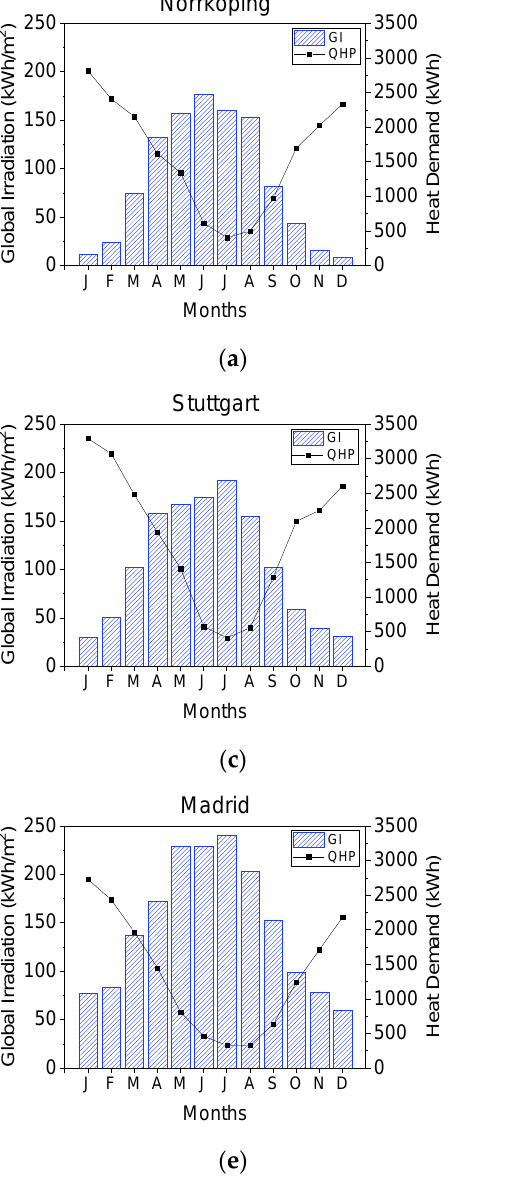
Figure 4. Monthly values for global irradiance (primary vertical axis) and total heat demand (secondary vertical) axis for all examined locations. ( a )–( f ) shows global irradiance and total heat demand respectively for each of the six examined locations.